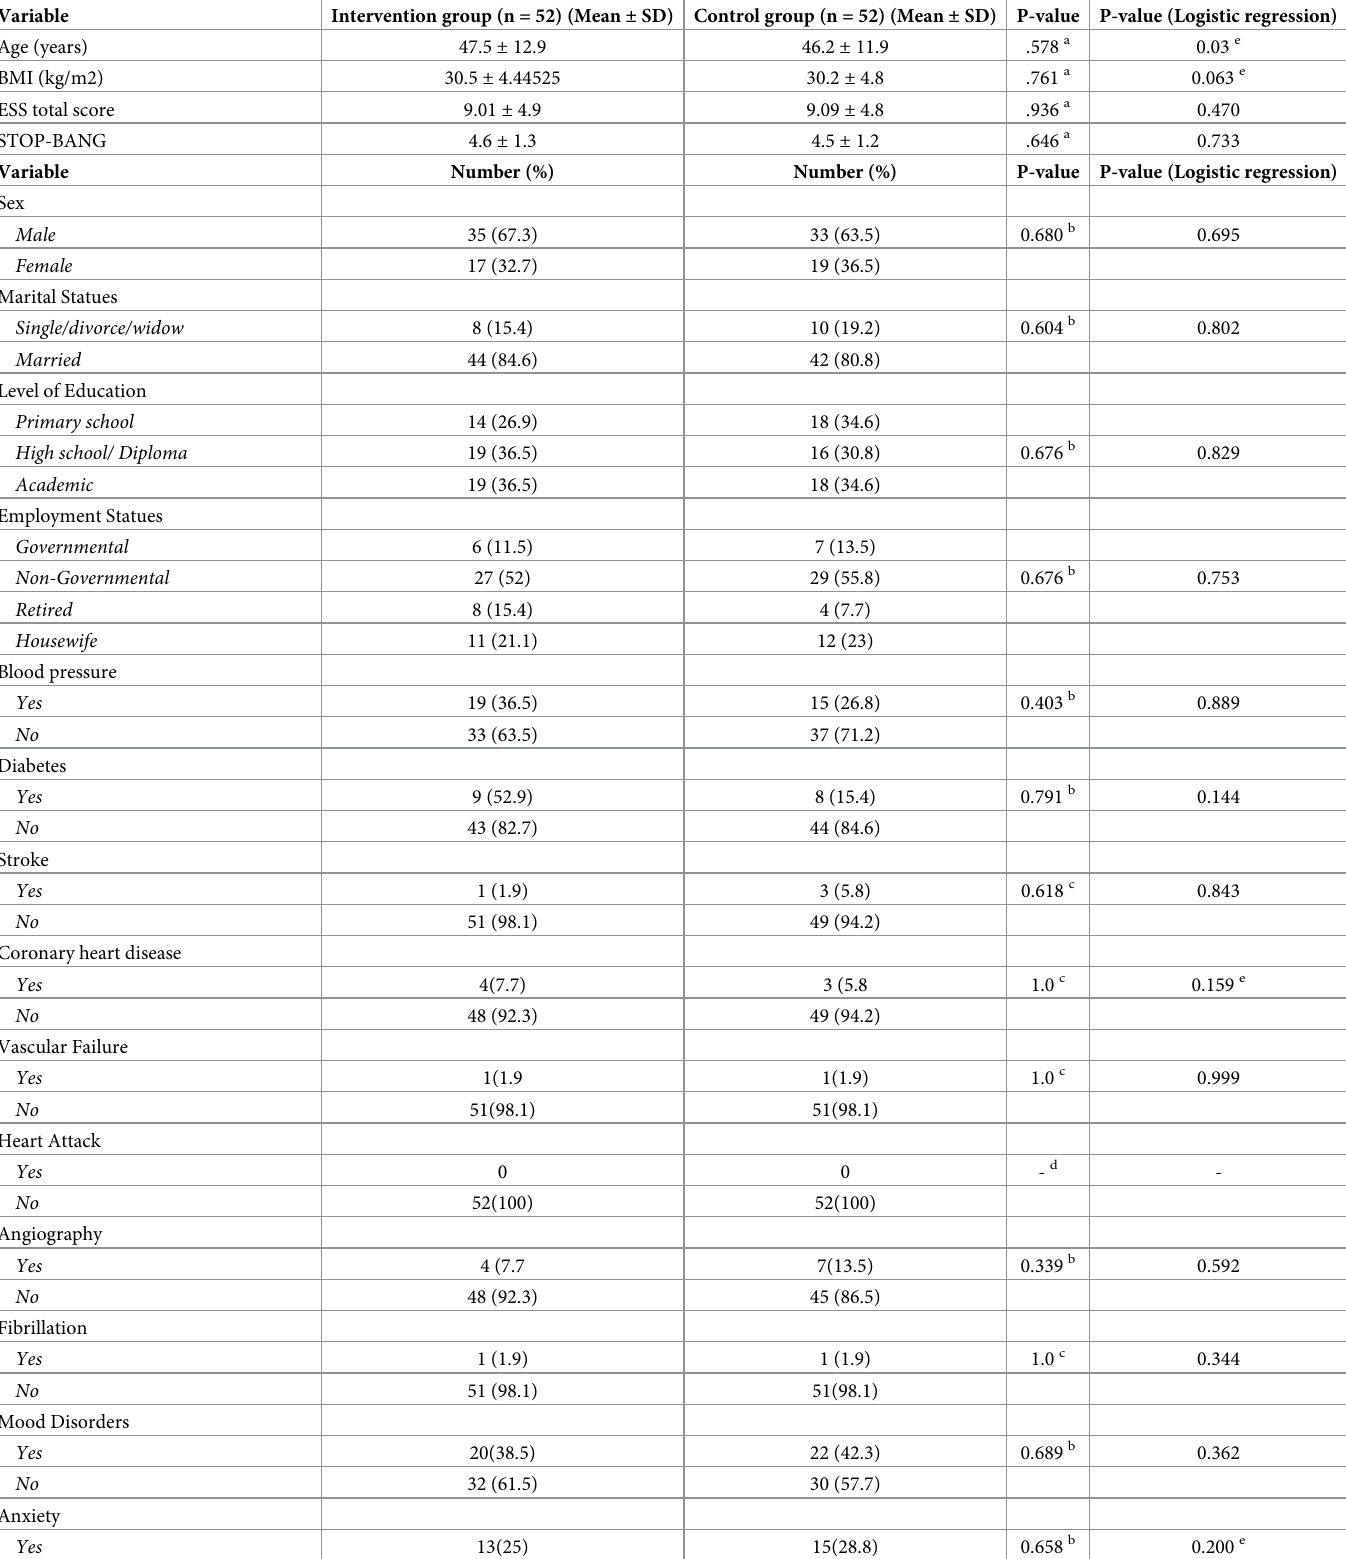
Table 2. Demographic characteristic of participants in research